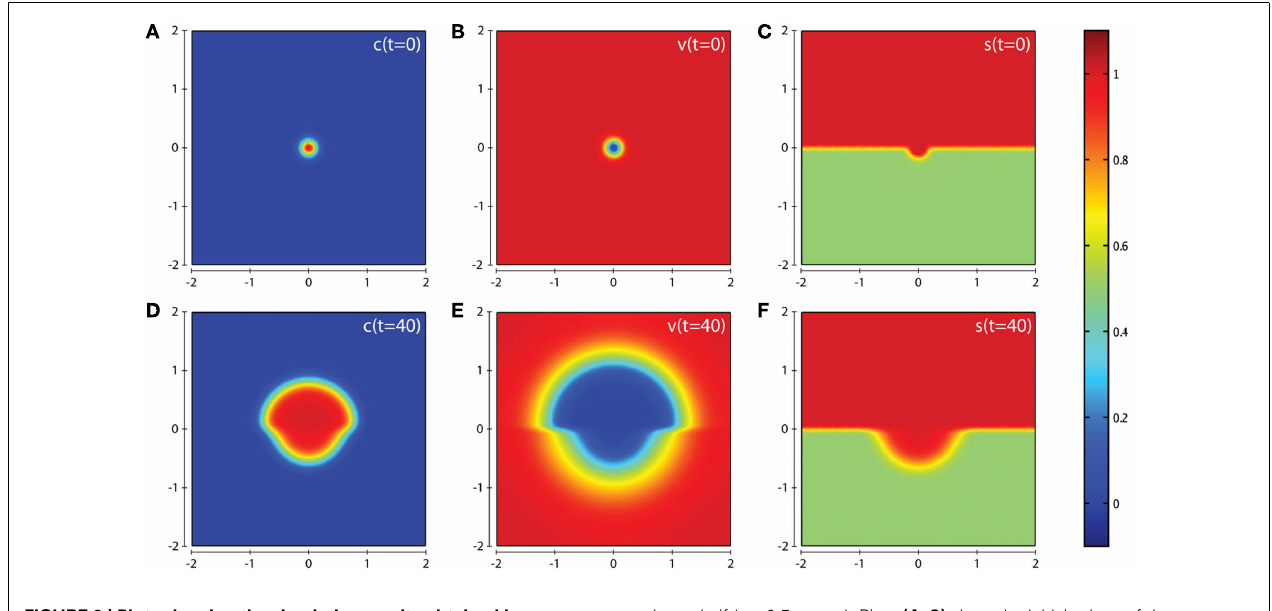
FIGURE 3 | Plots showing the simulation results obtained in a two-dimensional domain where asymmetric invasion of the ECM is achieved by the cancer cells. We use the matrix suitability modifier s to represent a medium with neutral abilities in the upper half of the region ( s = 1; red) and with a reduced, moderate, suitability for invasion in the